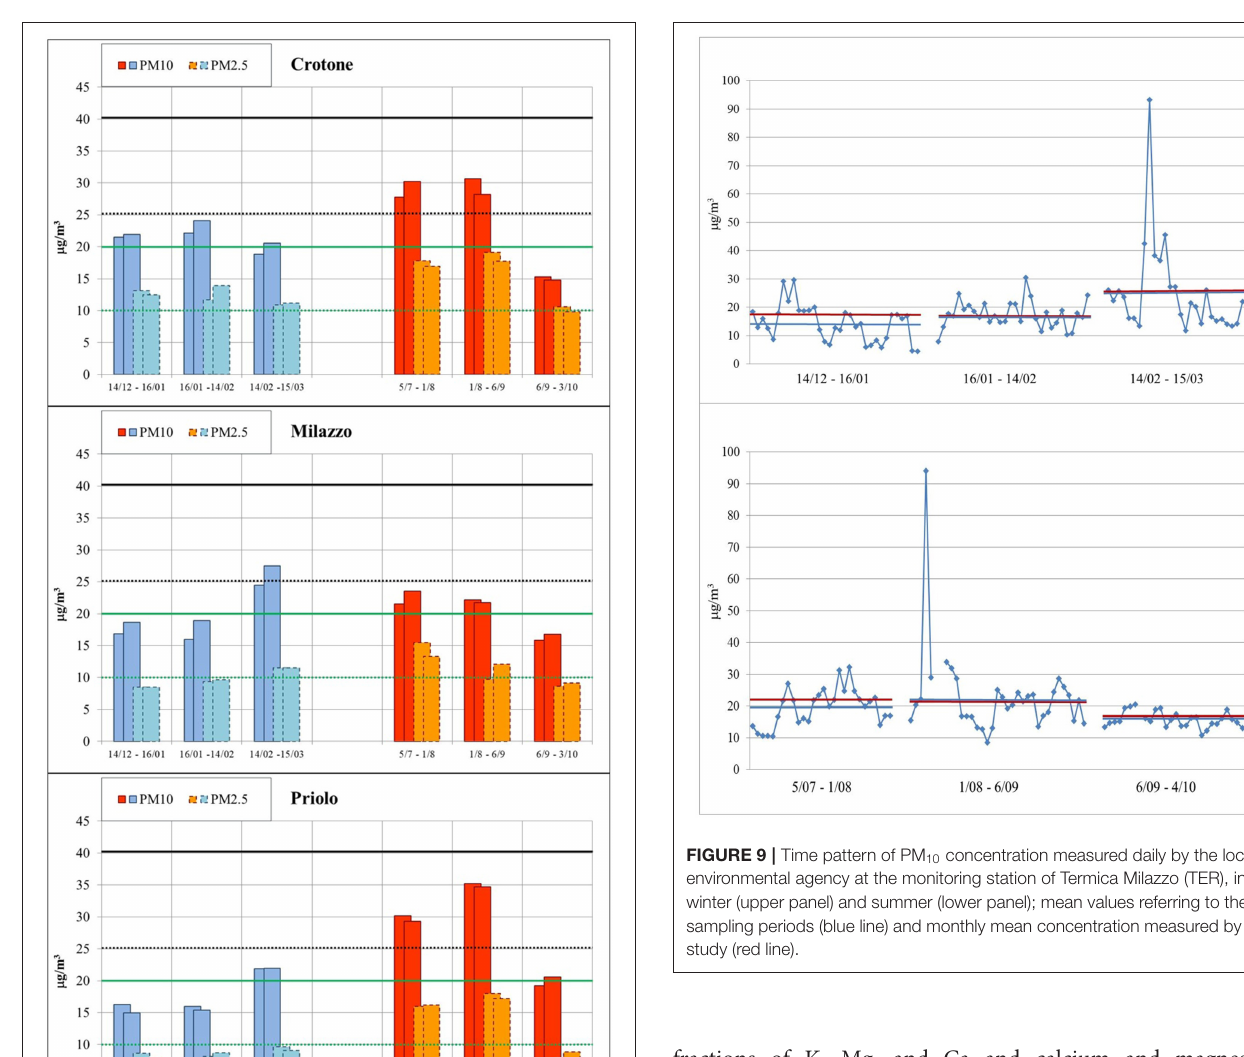
concentration (below 10 µ g/m 3 ) recorded during 16 of the 33